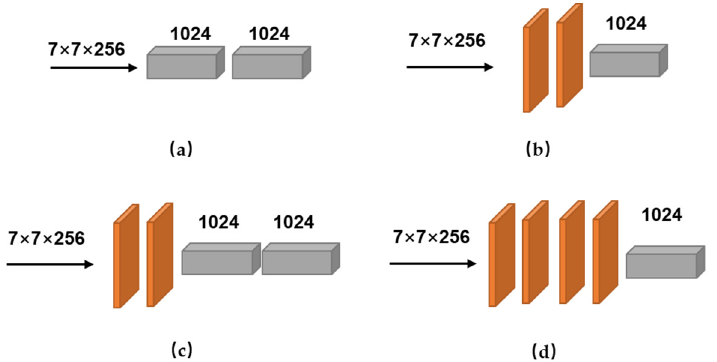
Figure 5. Different RCNN structures. ( a ) original RCNN structure with two FC layers. ( b ) two shared convolutional layers and one FC layer. ( c ) two shared convolutional layers and two FC layers. ( d ) four shared convolutional layers and one FC layer.